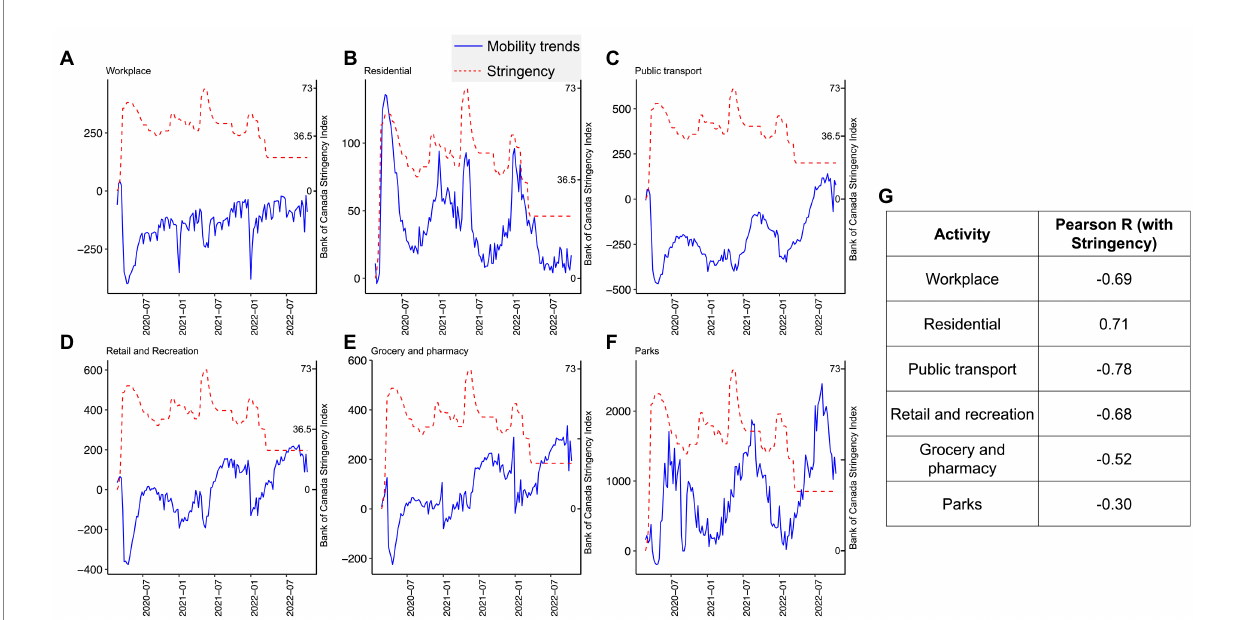
FIGURE 2 Nova Scotia mobility trends throughout the pandemic. We report mobility trends over six different activities throughout the COVID-19 pandemic. Workplace (A) , residential (B) , public transport (C) , retail and recreation (D) , grocery and pharmacy (E) , and parks (F) activities from the Google mobility reports service were considered. The 0 value in the y-axis indicates the baseline period Google assembled for the non- pandemic weeks from 3 January 2020 to 6 February 2020. In addition, we overlayed the stringency index of Bank of Canada in each one of the mobility panels. We scaled stringency with each mobility pattern following Equation 1 and replaced the variables (i.e., cases, hospitalizations, and deaths) by each one of the mobility metrics. In (G) , we performed a Pearson correlation analysis of the mobility trends with stringency. We report the coefficients.